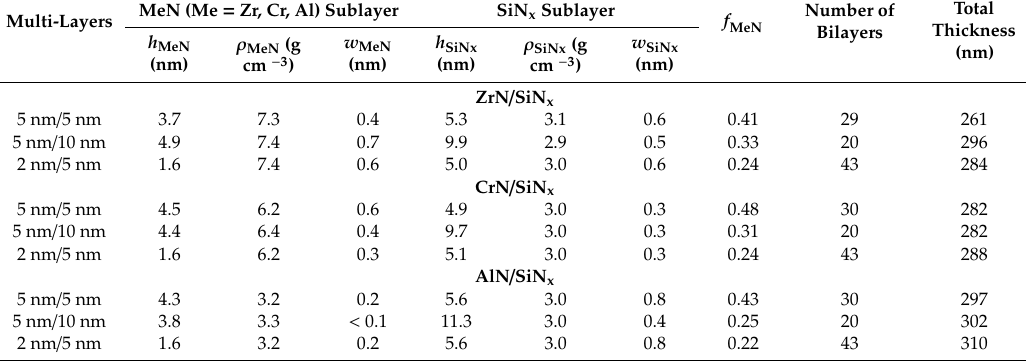
Table 2. Best-fit parameters as determined from simulations of XRR experimental data of MeN / SiN x (Me = Zr, Cr, Al) multilayers: elementary layer thickness ( h MeN and h SiNx ), mass density ( ρ MeN and ρ SiNx ), interface roughness ( w MeN and w SiNx ), MeN layer fraction ( f MeN ) and total film thickness. The first row indicates nominal thicknesses ratio for MeN / SiN x